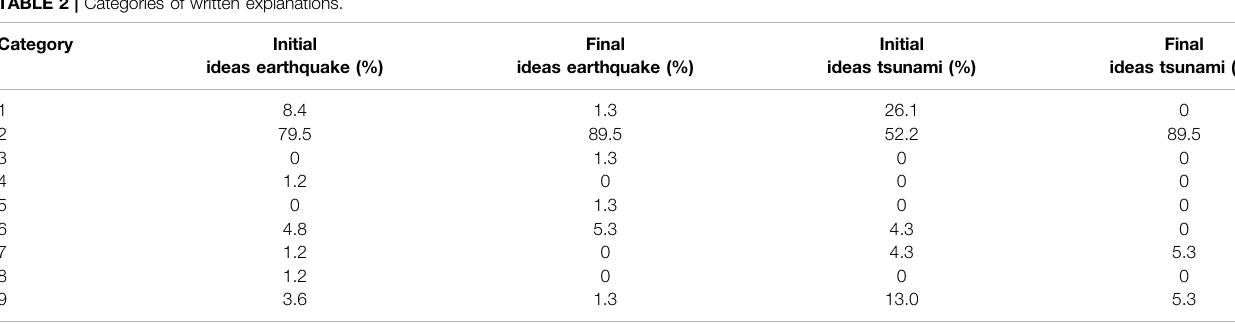
TABLE 2 | Categories of written